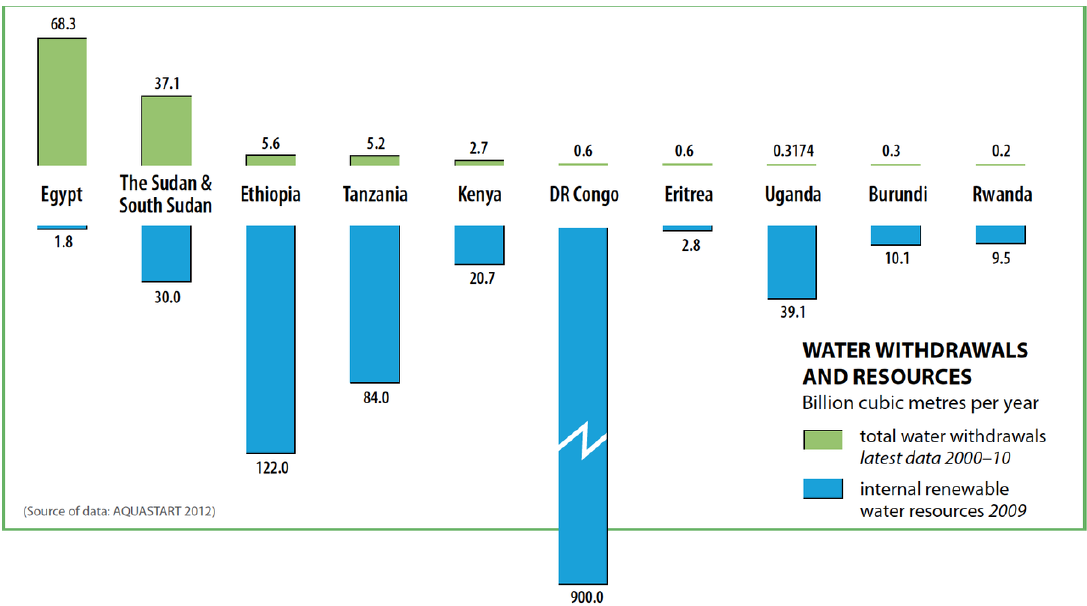
Figure 3. Nile Basin water withdrawals and resources. The top panel of the figure visualizes the total water withdrawals between 2000–2010. The lower panel illustrates the internal renewable water resources by 2009. Source (NBI, 2012) ([24], p. 51).